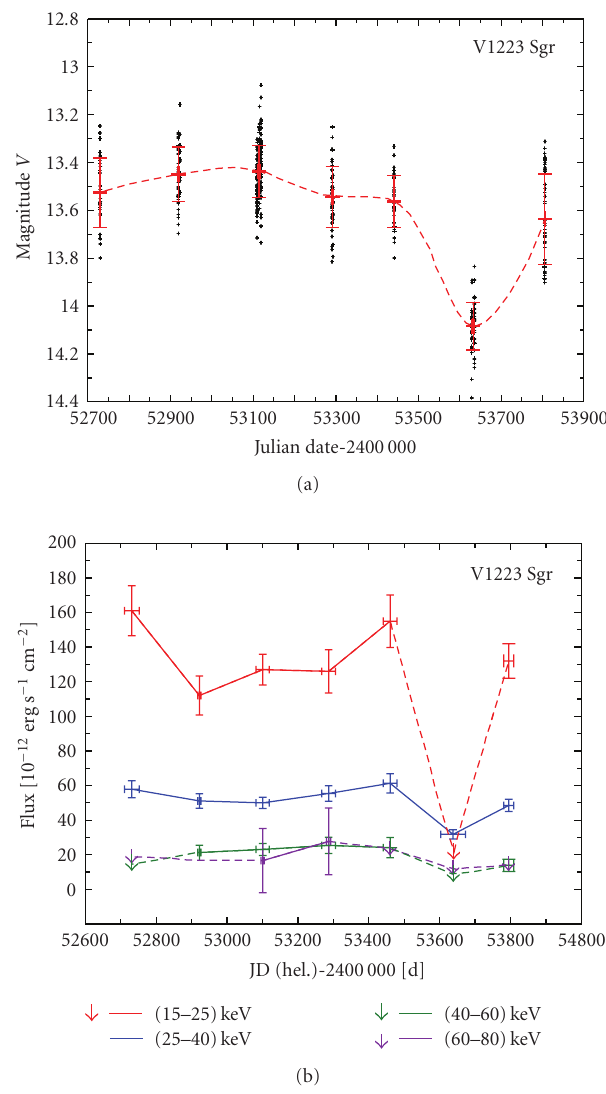
Figure 3: The X-ray (IBIS, (a)) and optical (OMC, (b)) light curves for V1223 Sgr. The fluxes especially in (15–25)keV and (25–40) keV bands are long-term variable with significant drop around MJD ∼ 53 650. Optical variations are correlated with the changes in (15–25) keV, (25–40) keV and (40–60)keV spectral bands with correlation coe ffi cient 0. 81, 0.82, and 0.89, respectively. The fluxes from INTEGRAL/JEM-X were persistent within their errors in monitored time period.